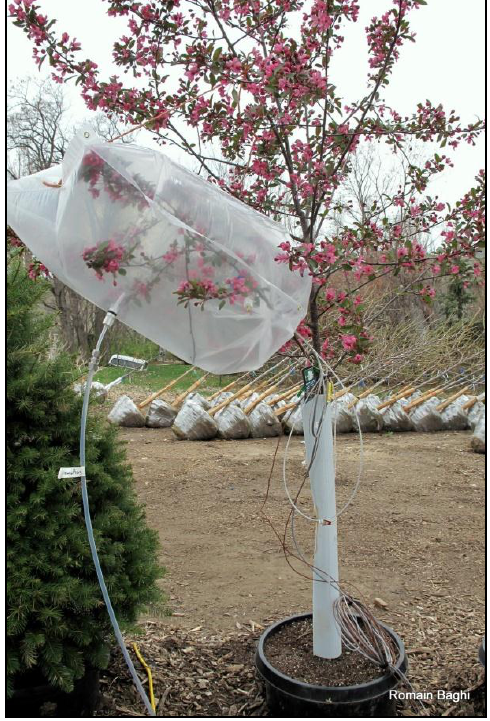
Fig. 1. Branch enclosure experiment setup on a crabapple tree dur- ing its flowering